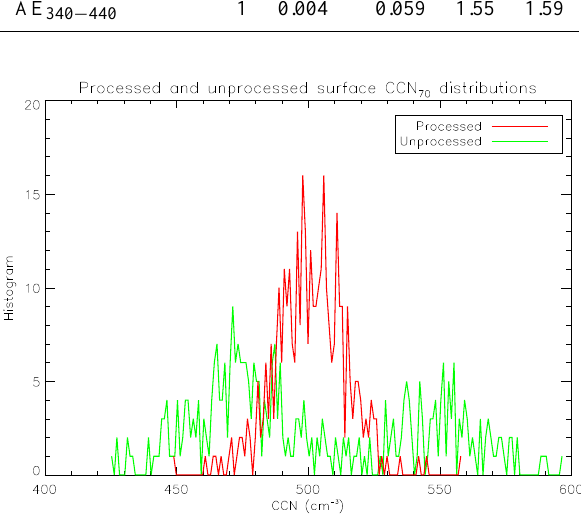
Fig. 3. Histograms showing the distribution of processed and un- processed surface CCN 70 concentrations. The null hypothesis that the red line (processed) is normally distributed is not rejected by the Lilliefors